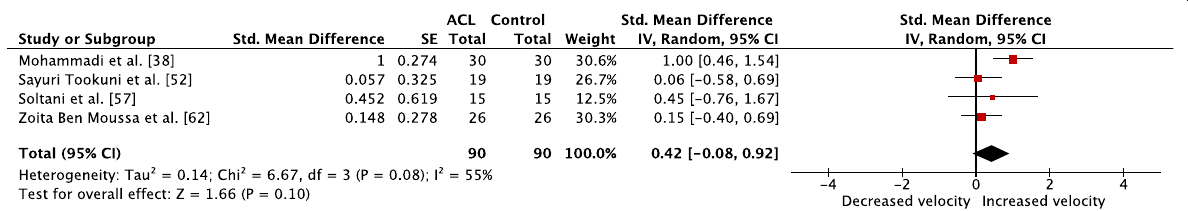
Fig. 9 Forest plot comparison of sway velocity between the ACL-injured leg and ACL-non-injured leg. Std . standardized, SE standard error, IV inverse variance, CI confidence interval, df degrees of freedom, ACL anterior cruciate